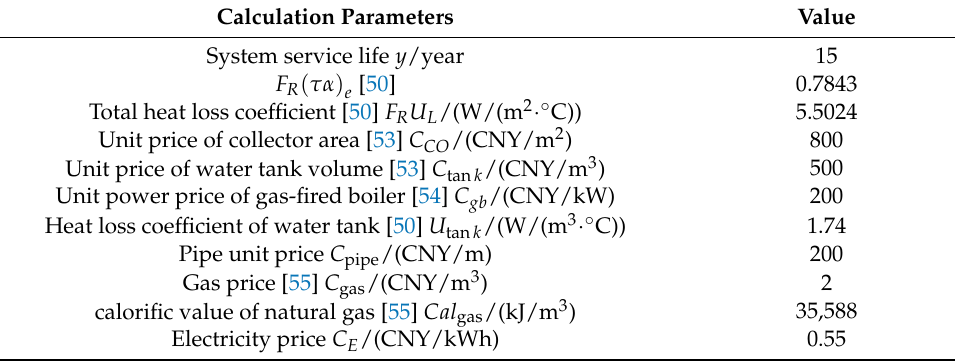
Table 2. Calculation parameter